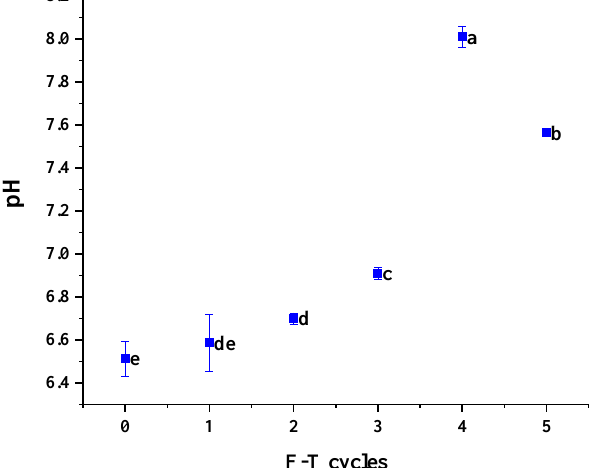
Figure 3. The pH value of cuttlefish after freeze–thaw cycles. Error bars show standard deviation. The letters “a–e” indicate significant differences ( p < 0.05).